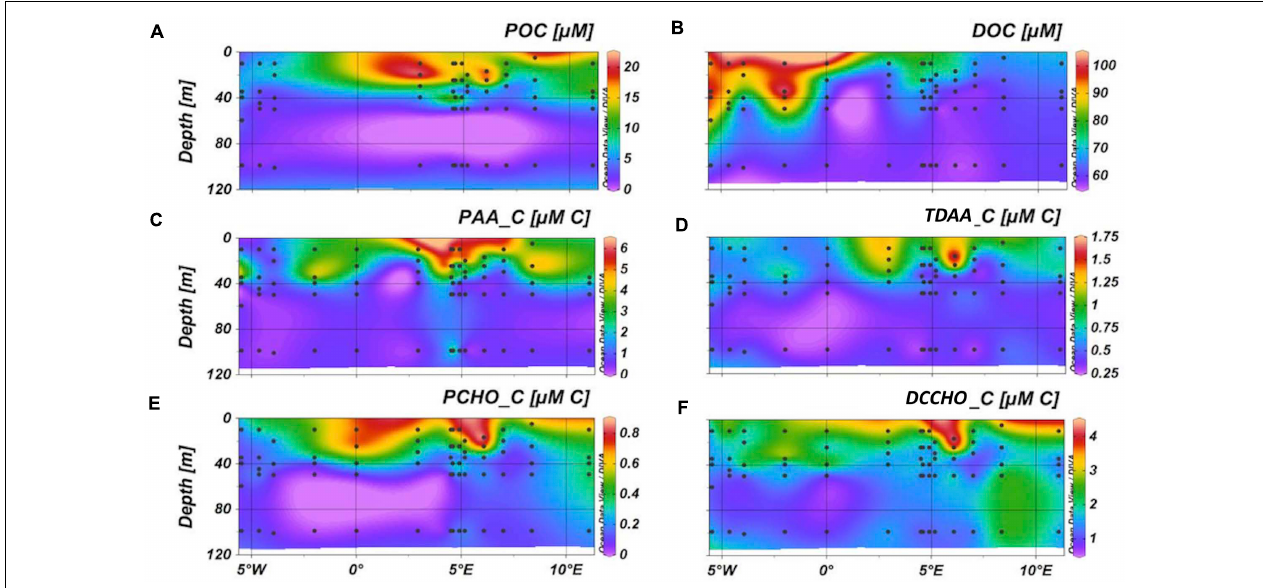
FIGURE 3 | Distribution of particulate and dissolved organic carbon across Fram Strait (A,B) and contribution of amino acids (C,E) and carbohydrates (D,F) to carbon with these